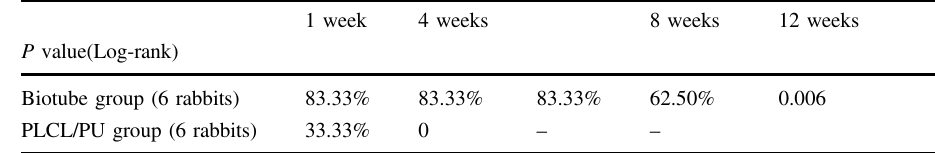
Table 1 Kaplan-Meier curves showing primary patency of the grafts in biotube group and PLCL/PU group